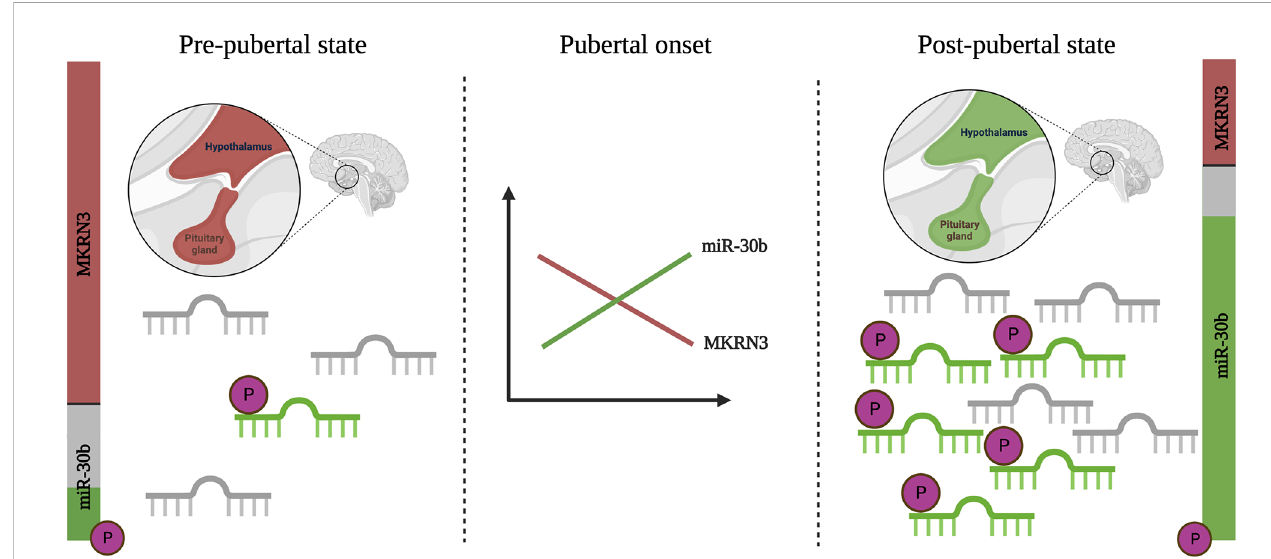
FIGURE 4 Schematic illustration of changes in miR-30b levels and bioactivity during pubertal transition. Circulating levels of miR-30b are low in pre-pubertal boys and a large fraction of these appears unphosphorylated at the 5 ’ end (inactive, shown in grey). At the same time, levels of Makorin RING- fi nger protein 3 (MKRN3) in circulation are high (shown in red) in pre-pubertal boys. As puberty progresses, levels of miR-30b increase and a larger fraction appear to be biologically active with a 5 ’ -phosphorylation (shown in green). A concurrent drop in the circulating level of MKRN3 is observed. While the data builds on measurements in blood, we believe that these, at least to some extent, re fl ect hypothalamic activation of the kisspeptin/neurokinin B/dynorphin positive (KNDy-) neurons, which are known from studies in animals to be involved in the onset of puberty. Created with